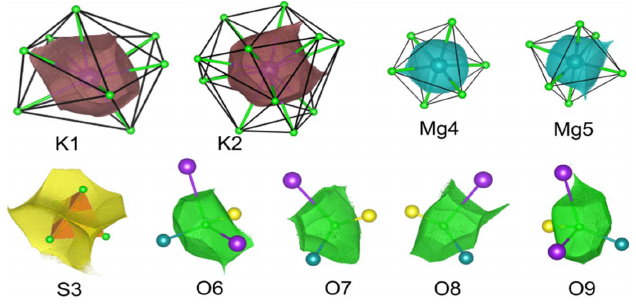
Figure 7 Relation between the polyhedral representation of ions in the crystal structure of Lb and atomic/ionic basins of particular